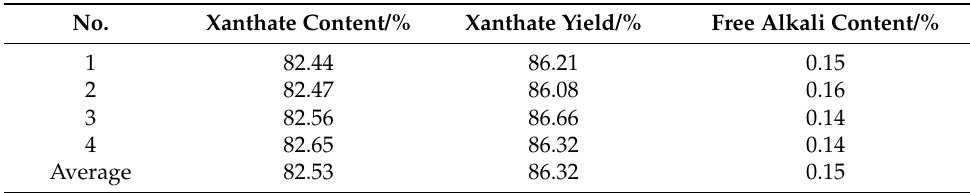
Table 4. Reproducible experimental